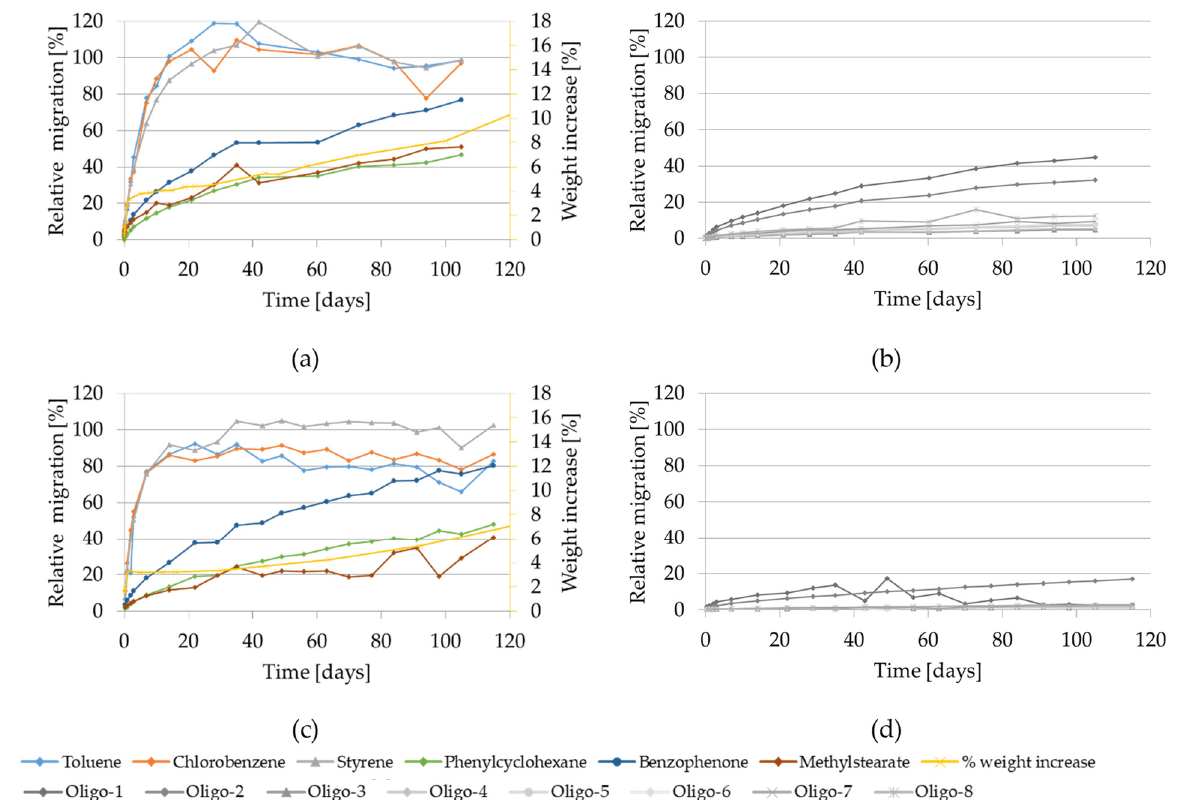
Figure 4. Migration kinetics and weight increase in 95% ethanol at 60 °C: ( a ) Model substances and styrene from GPPS; ( b ) Styrene oligomers from GPPS. ( c ) Model substances and styrene from HIPS; ( d ) Styrene oligomers from HIPS.